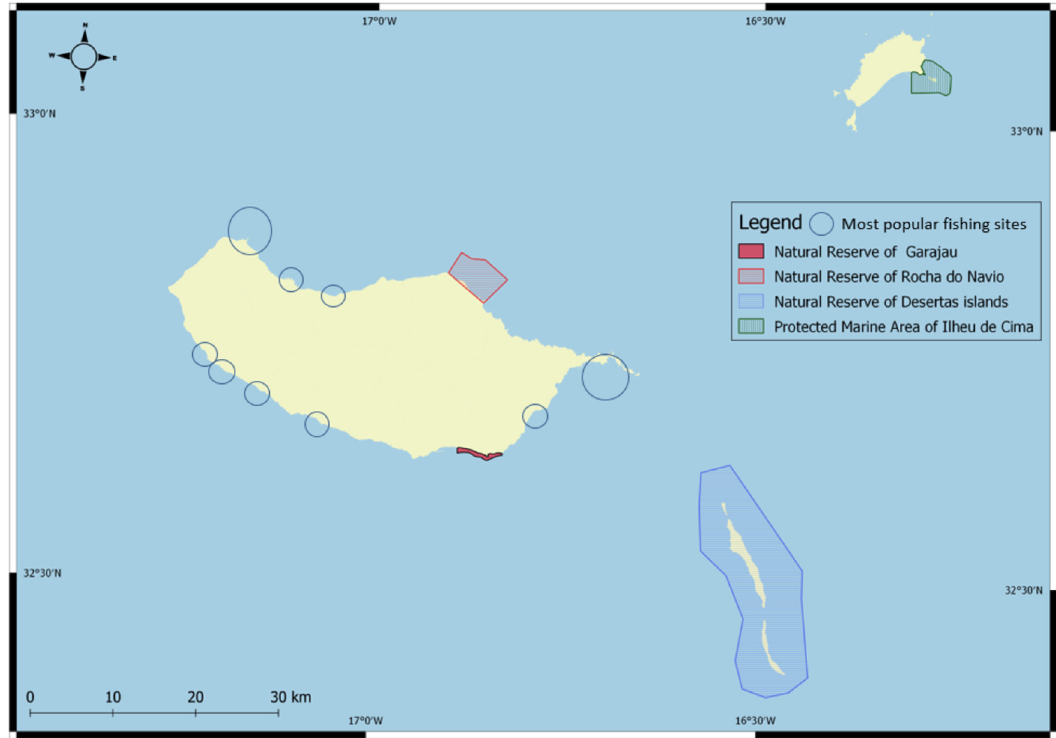
Fig. 1. Map of Madeira with most popular fi shing sites (circle size re fl ects spear fi shers preference) and areas where spear fi shing is banned (Marine Protected Areas “ Rocha do Navio ” , “ Ponta do Garajau ” , Marine Protected Areas in Porto Santo Island (Ilhéu de Cima), and Desertas islands classi fi ed as a special protection area since 1990 and as a reserve since 1992 (Quintal,